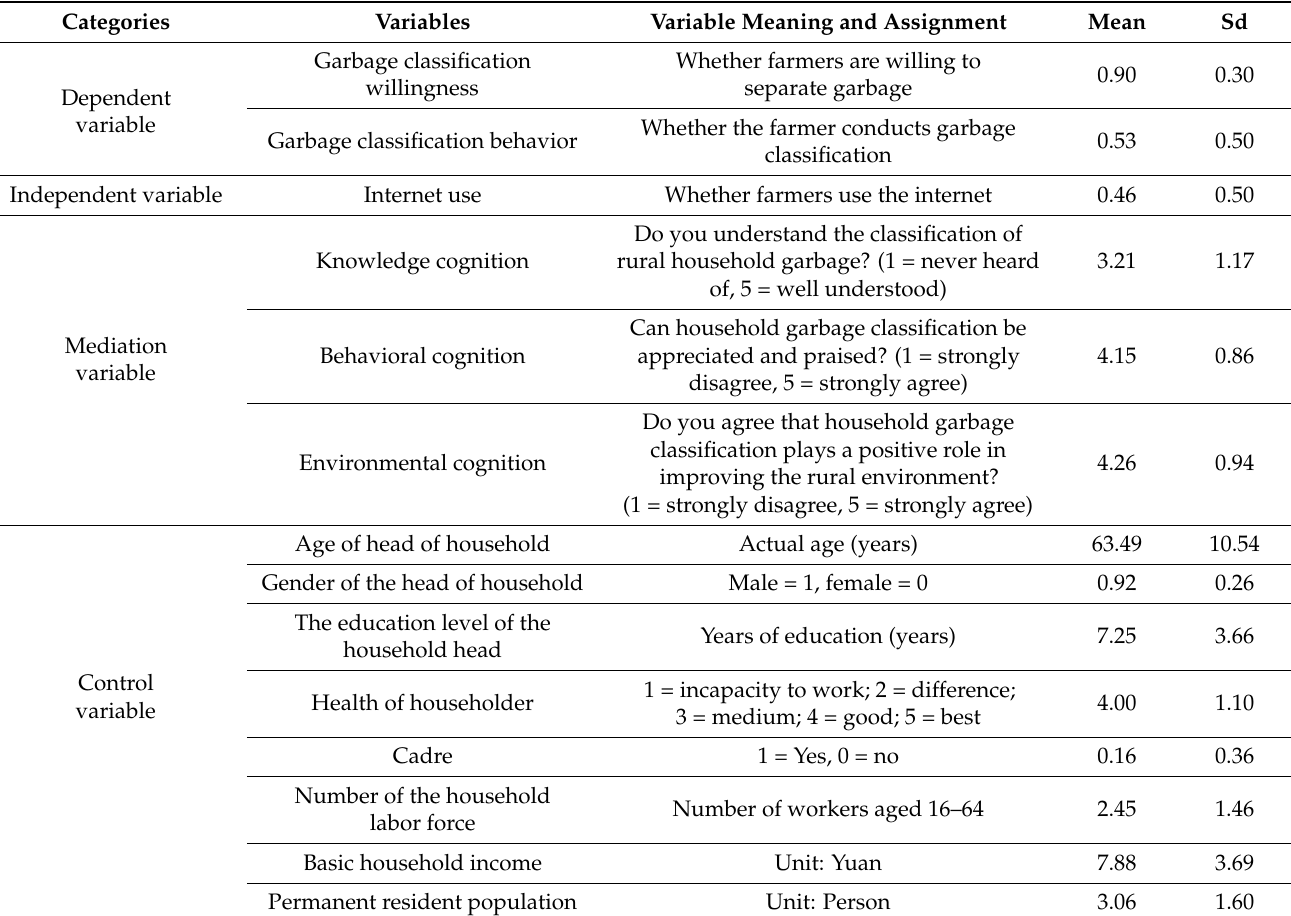
Table 1. Description of variable assignment and descriptive